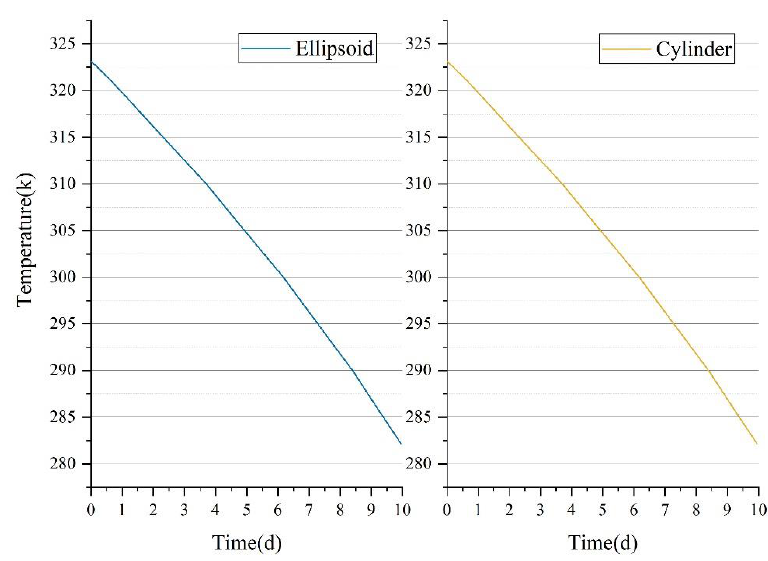
Figure 10. Diagram of temperature over time.